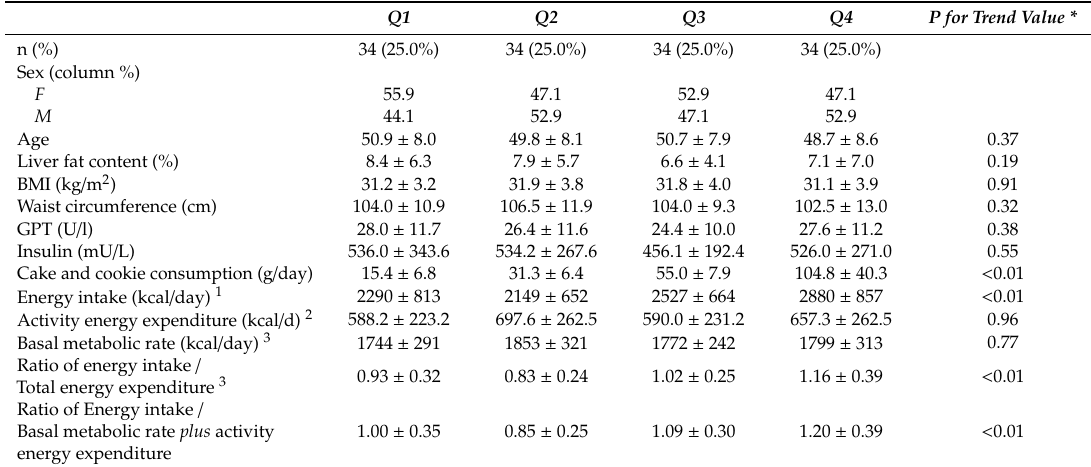
Table A3. Characteristics of the study population according to FFQ-derived cake and cookie consumption ( n =